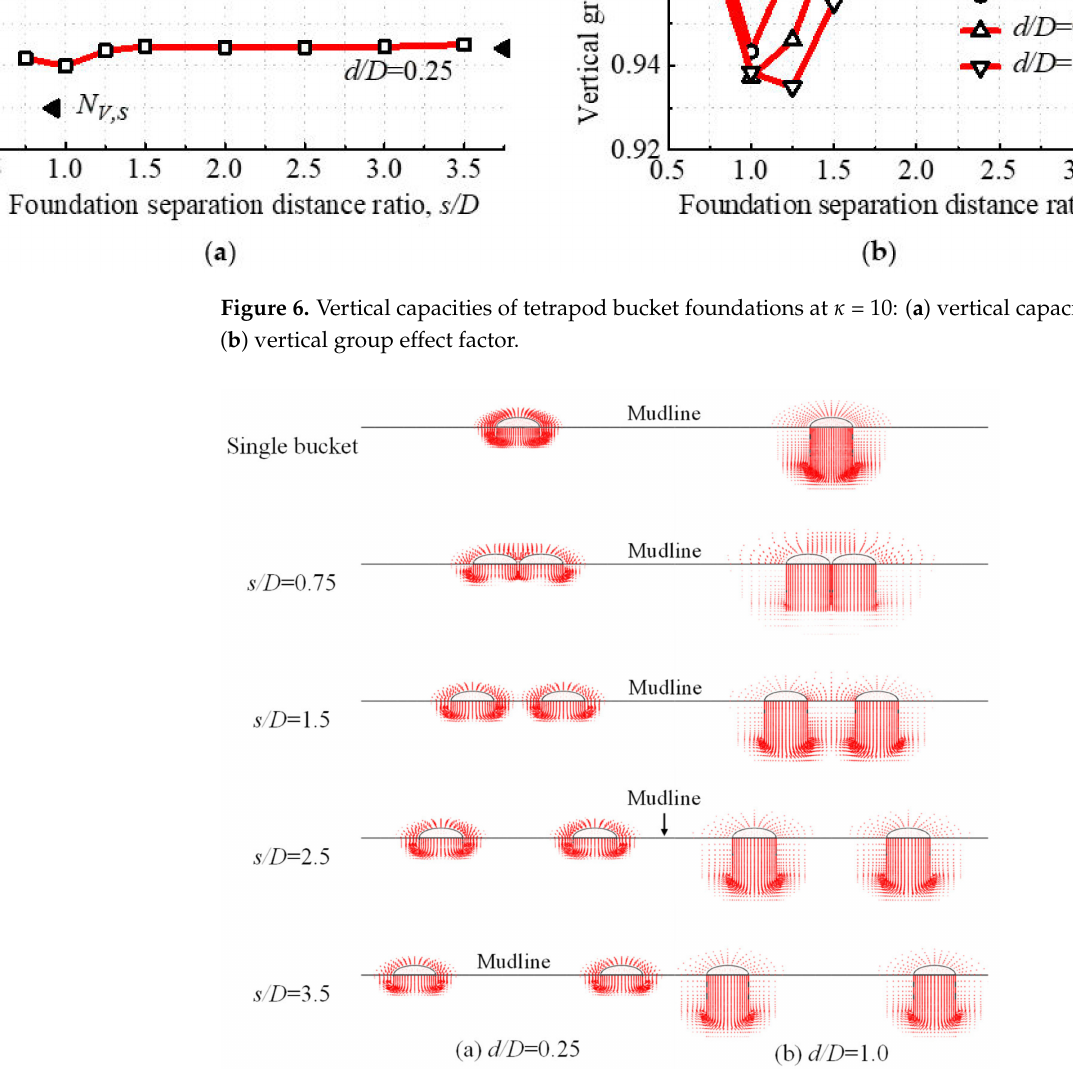
Figure 7. The vector fields of the displacement of the single bucket foundation and tetrapod bucket foundations under ultimate vertical loading at κ = 10 when ( a ) d/D = 0.25 and ( b ) d/D =